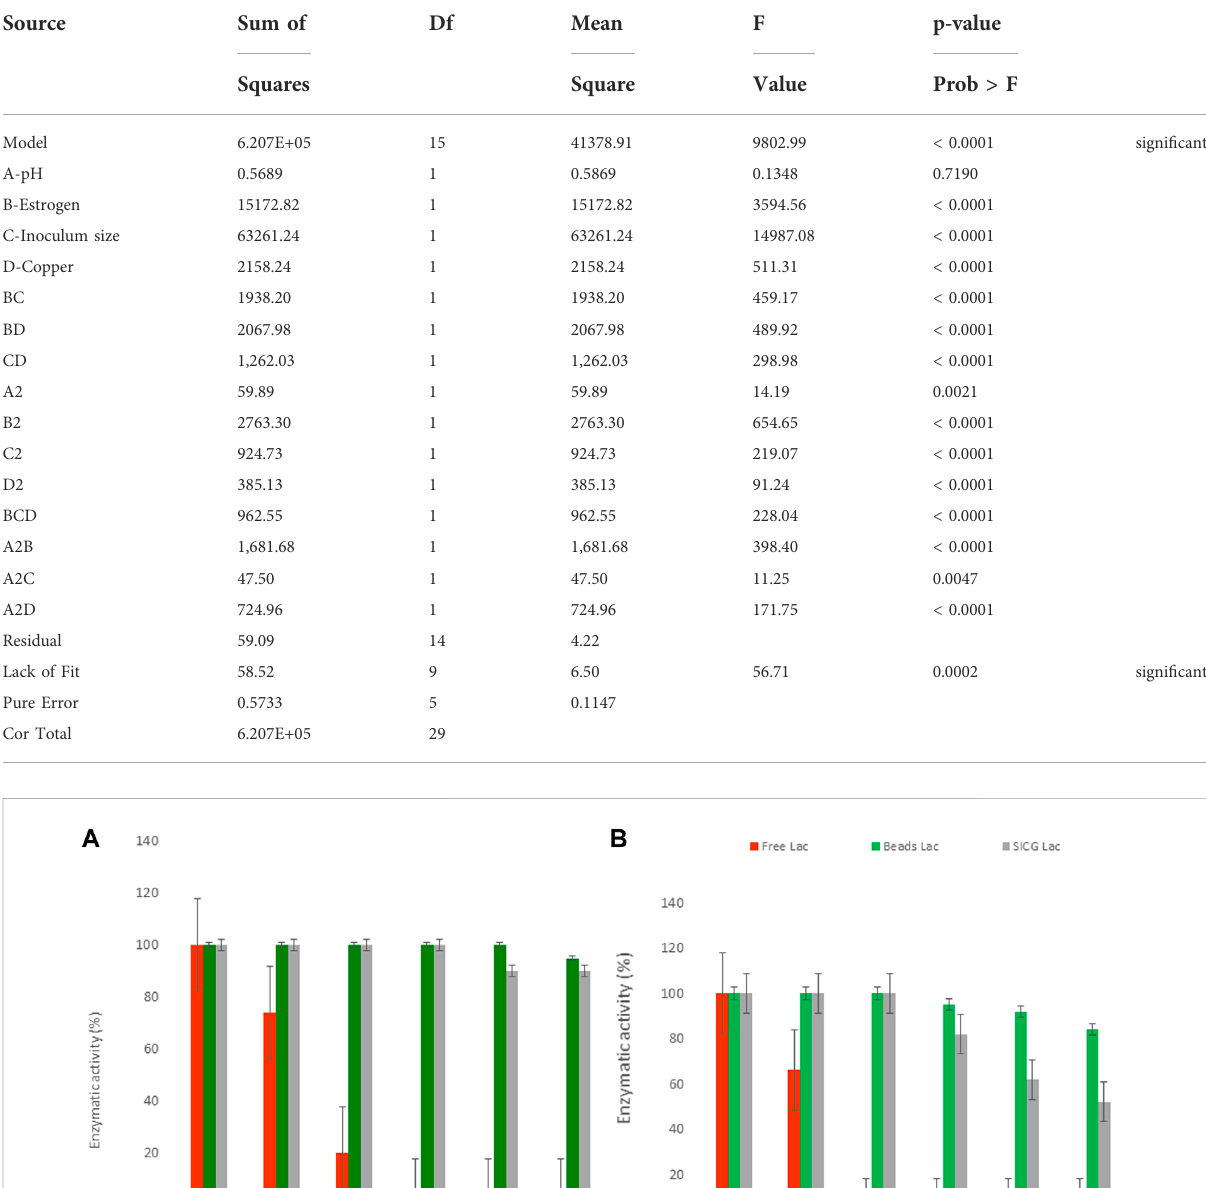
TABLE 3 Reduced cubic ANOVA model for Lysinibacillus. BP1 (A) laccase activity